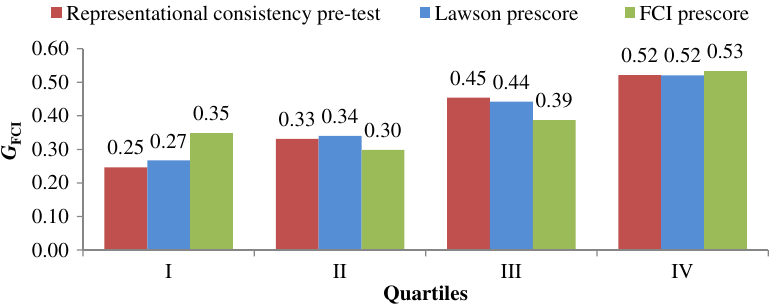
FIG. 7 (color online). Average of single student normalized FCI gain ( G FCI ) in quartiles of representational consistency on the R-FCI pretest, Lawson prescores, and FCI